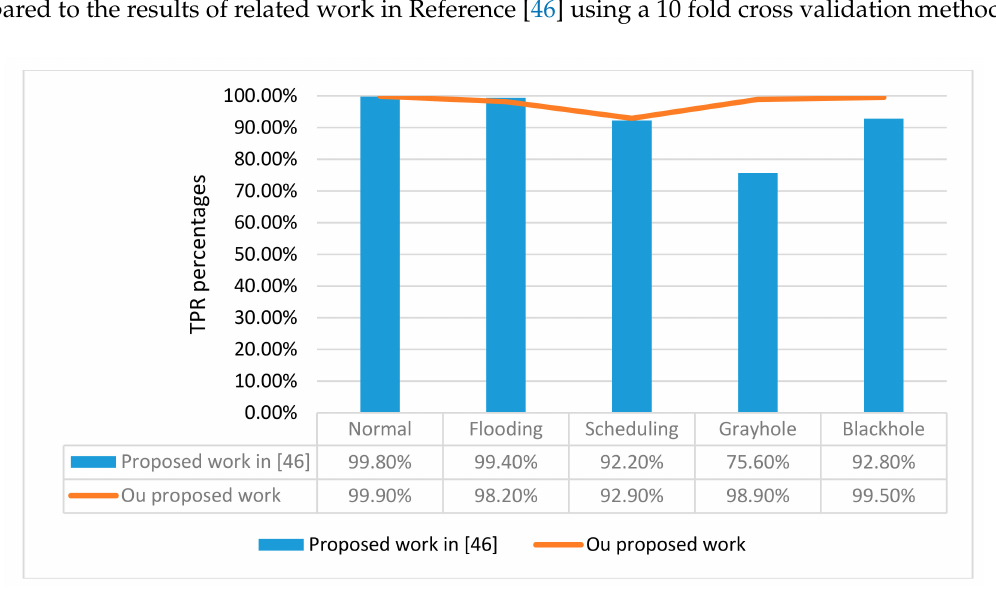
Figure 5. TPR percentage values of the proposed GXGBoost compared to the results of related work in Reference [46] using 10 fold cross validation